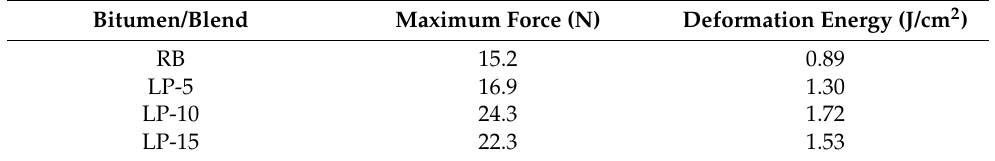
Table 5. Force ductility results at 15 ◦